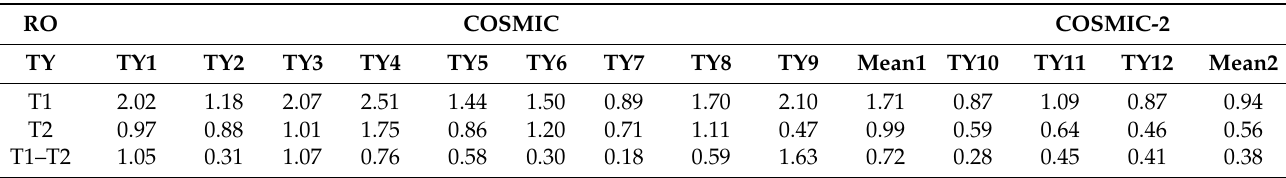
Table 1 indicates the six stages of typhoons classified by the CMA. In this section, the first three stages (TD, TS, and STS) were merged into T1 and the last three stages (TY, STY, and super TY) were merged into T2 to give a preliminary result of the temporal variations in the ABLHs of T1 and T2 in the twelve typhoons. Table 4 shows the results based on a 12 h time window. The values in the Mean1 and Mean2 columns denote the mean ABLHs of TY1–TY9 and TY10–TY12, respectively, and the value in the T1–T2 row is the difference between the results of the T1 and T2 rows. Among the values of TY1–TY9 in the T1–T2 rows, the minimum was 0.18 km, derived from TY7, while the maximum was 1.63 km, derived from TY9. This results from the fact that TY9 occurred in 2016, during which the COSMIC mission approached completion, and thus the amount of RO data was limited. For COSMIC-2, the ABLH during TY10–TY12 also showed the same characteristics as TY1–TY9. All the positive values in the T1–T2 row in Table 4 indicate that the ABLH at T1 was larger than that at T2, and the ABLH at T2 was, on average, 0.72 km and 0.38 km lower than the ABLH at T1, based on COSMIC and COSMIC-2, respectively. Table 4. ABLH (km) of T1 (mean of TD, TS and STS) and T2 (mean of TY, STY, and super TY) of each typhoon resulting from the co-located RO profiles within the 12 h time window. RO